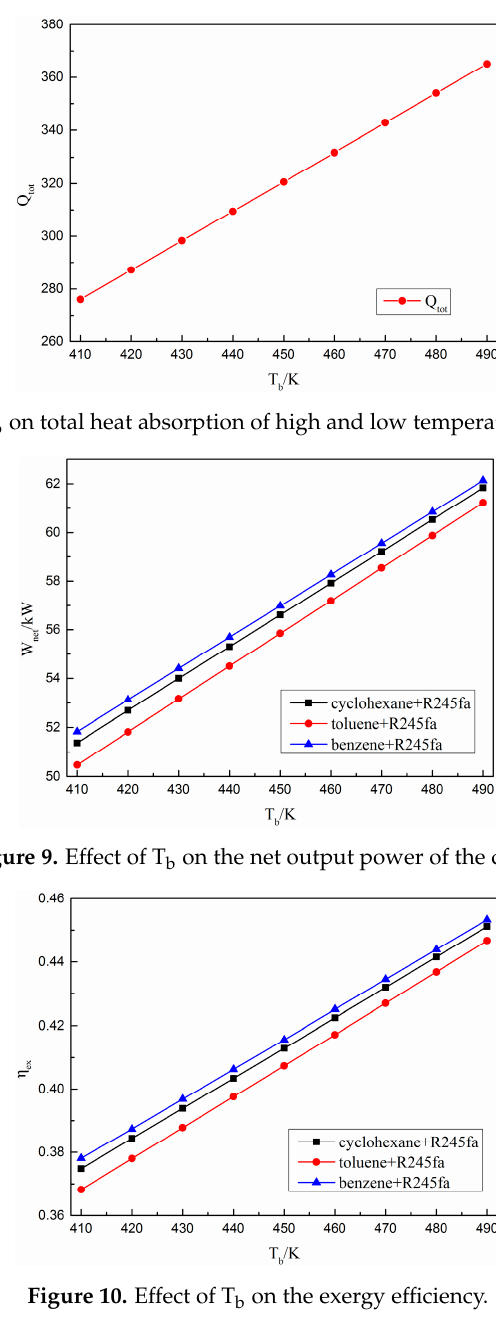
Figure 10. Effect of T b on the exergy efficiency.